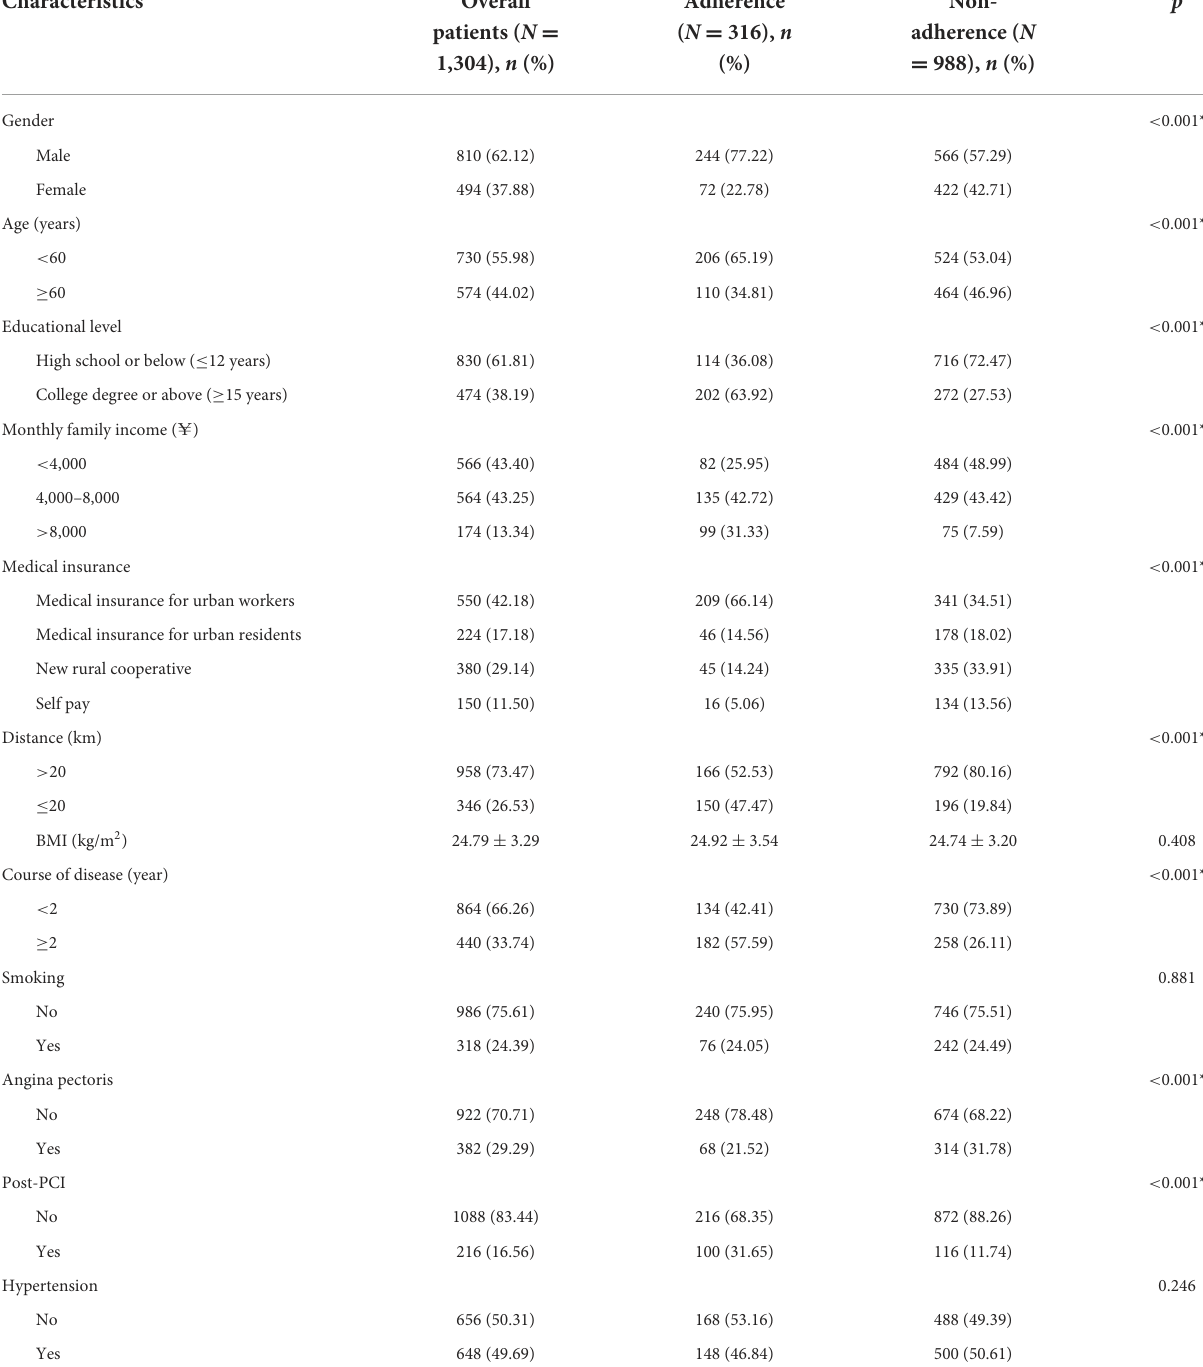
TABLE 1 Demographic characteristics of coronary heart disease patients.